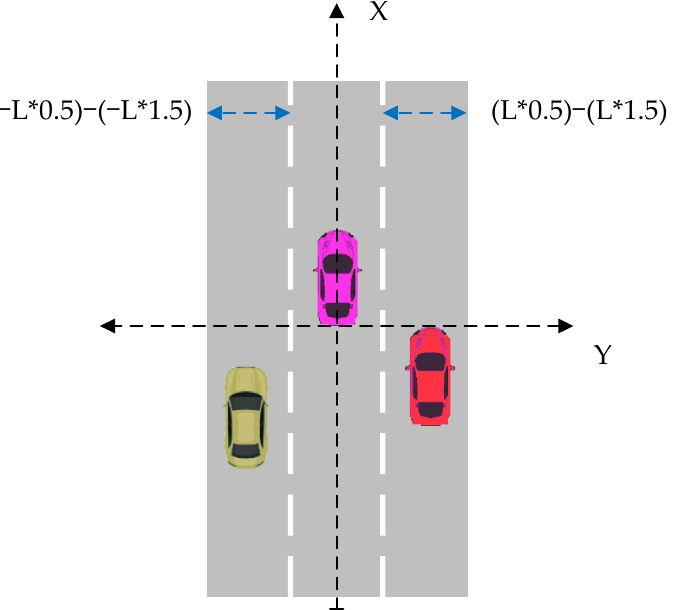
Figure 1. Schematic diagram of the algorithm for overtaking recognition in lanes on both sides of the main vehicle.